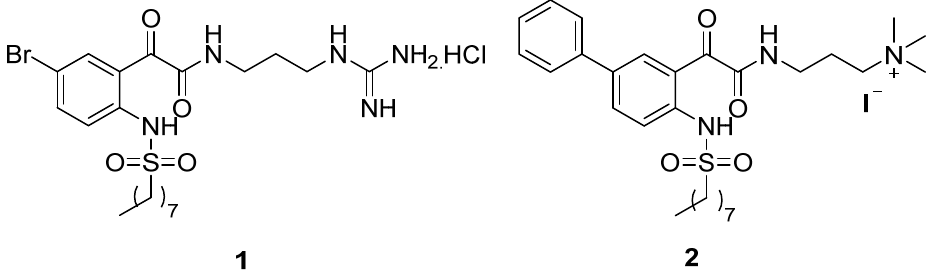
Figure 1. Structures of phenylglyoxamide- and biphenylglyoxamide-based small molecular antimicrobial peptidomimetics 1 and 2 .